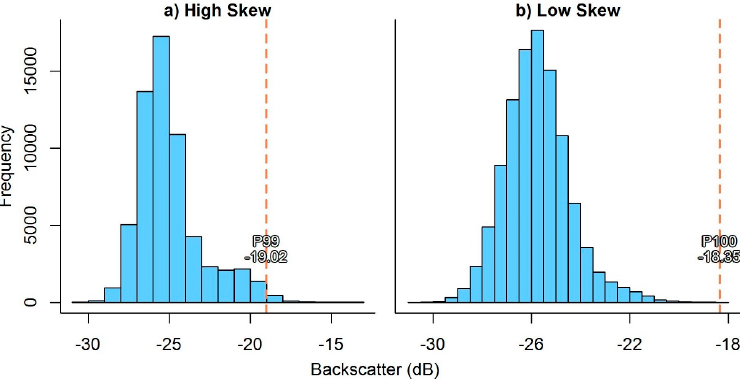
Figure 4. Comparison of threshold selection as a function of ( a ) high and ( b ) low skew backscatter distributions.